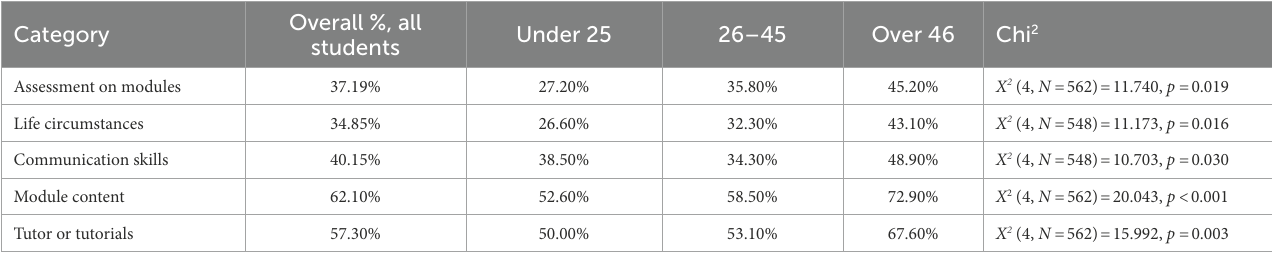
TABLE 4 Survey findings: enablers by age.